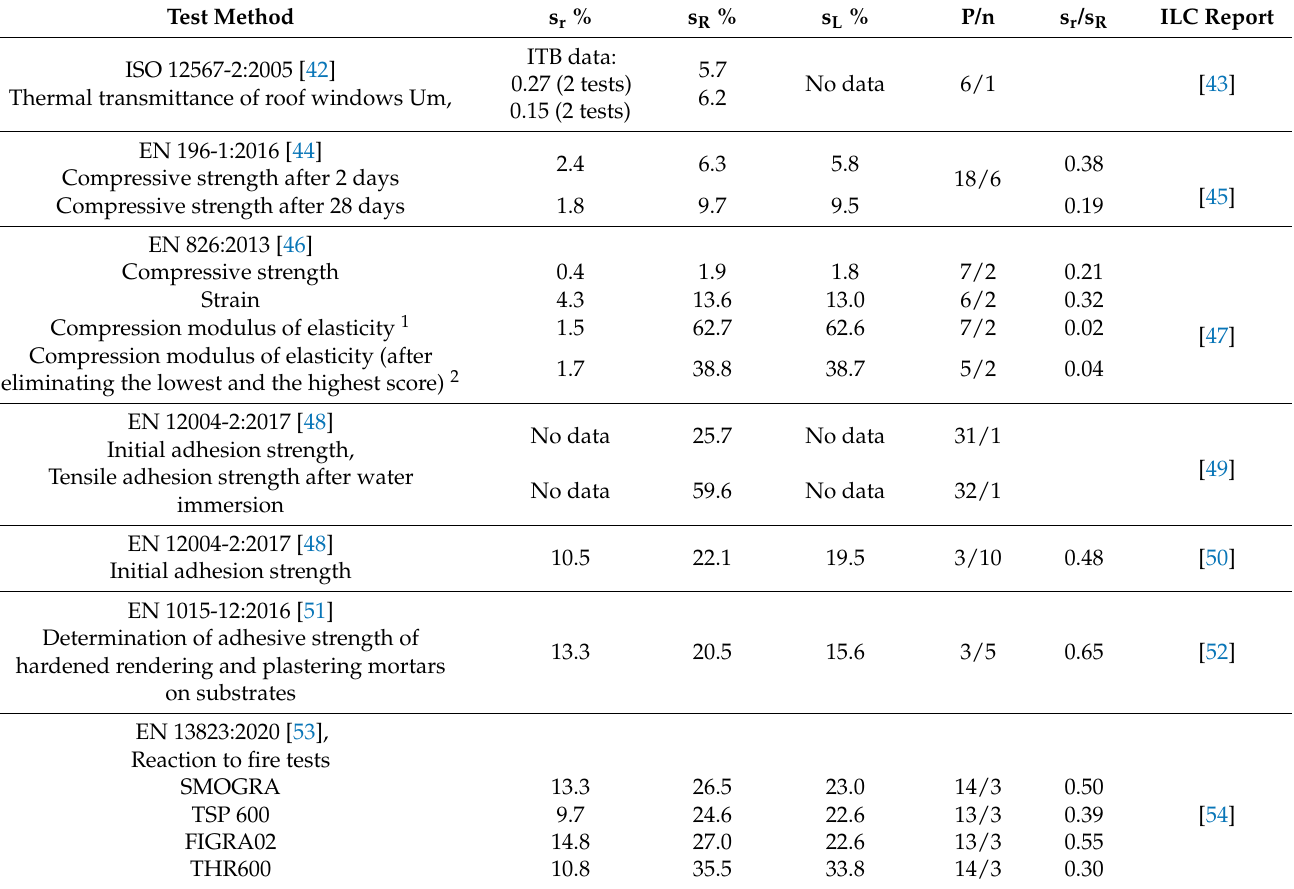
Table 2. Analysis of ILC Reports data. The values of interlaboratory standard deviation (s L ), repeata- bility (s r ) and reproducibility (s R ) standard deviations are expressed as percentage of the general mean for the reference ILC. P/n—number of laboratories/number of results for